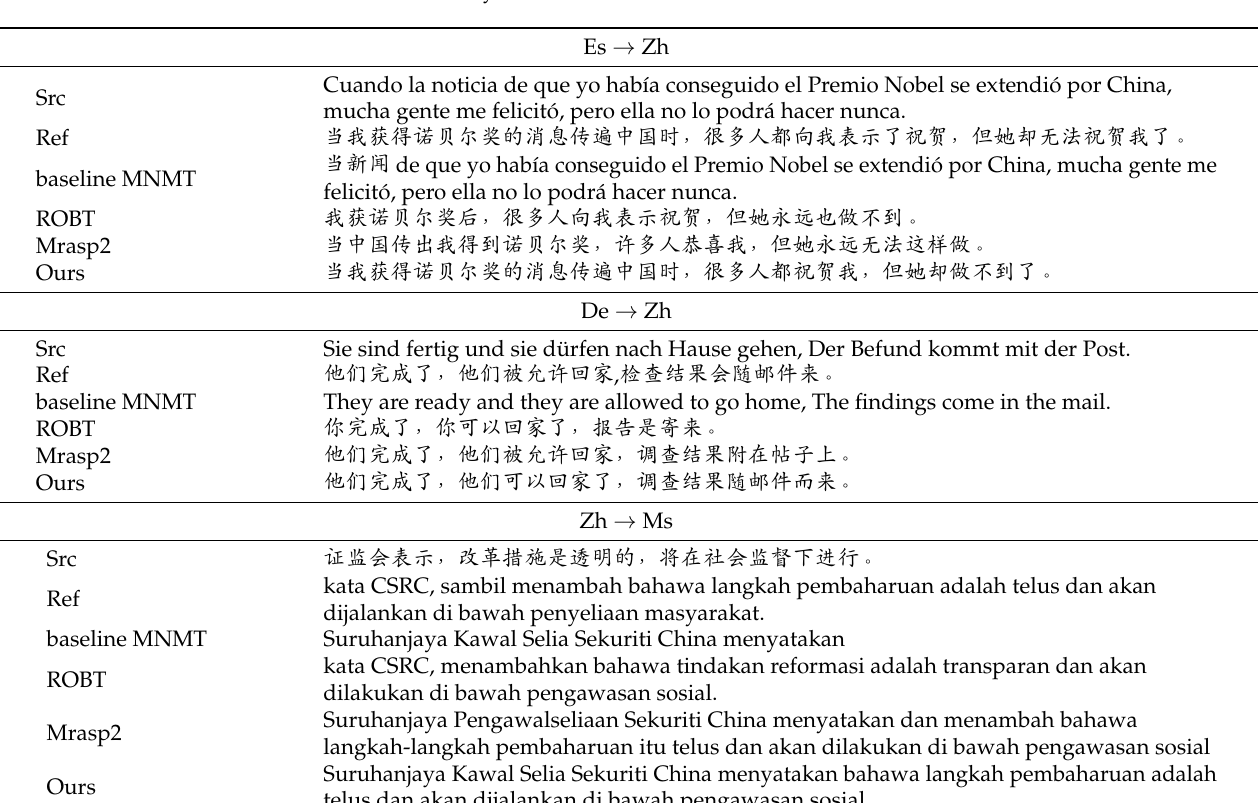
Table 7. Case Study.